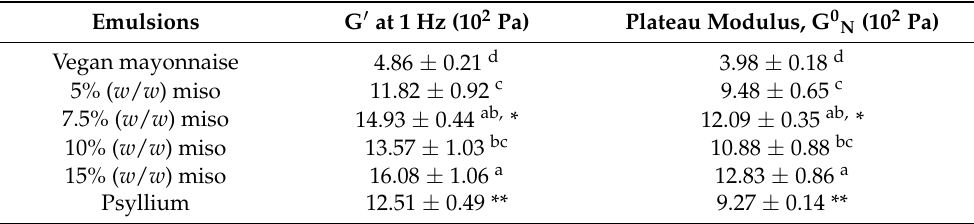
Table 4. Parameters (G (cid:48) at 1 Hz and G 0 N ) from mechanical spectra of standard and miso emulsions. Different letters indicate significantly different results ( p < 0.05) according to Tukey test. Different amounts of asterisks indicate significantly different results ( p < 0.05) according to t